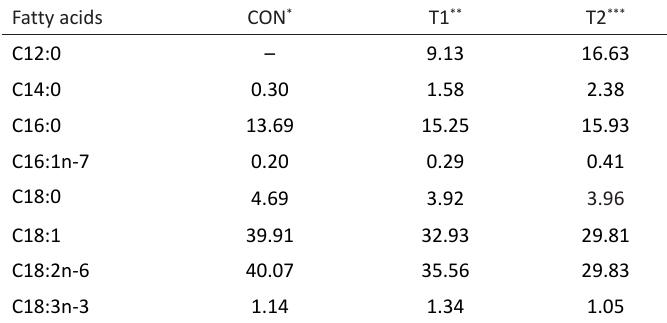
Table 2. Fatty acid composition (% FAME) of the diets